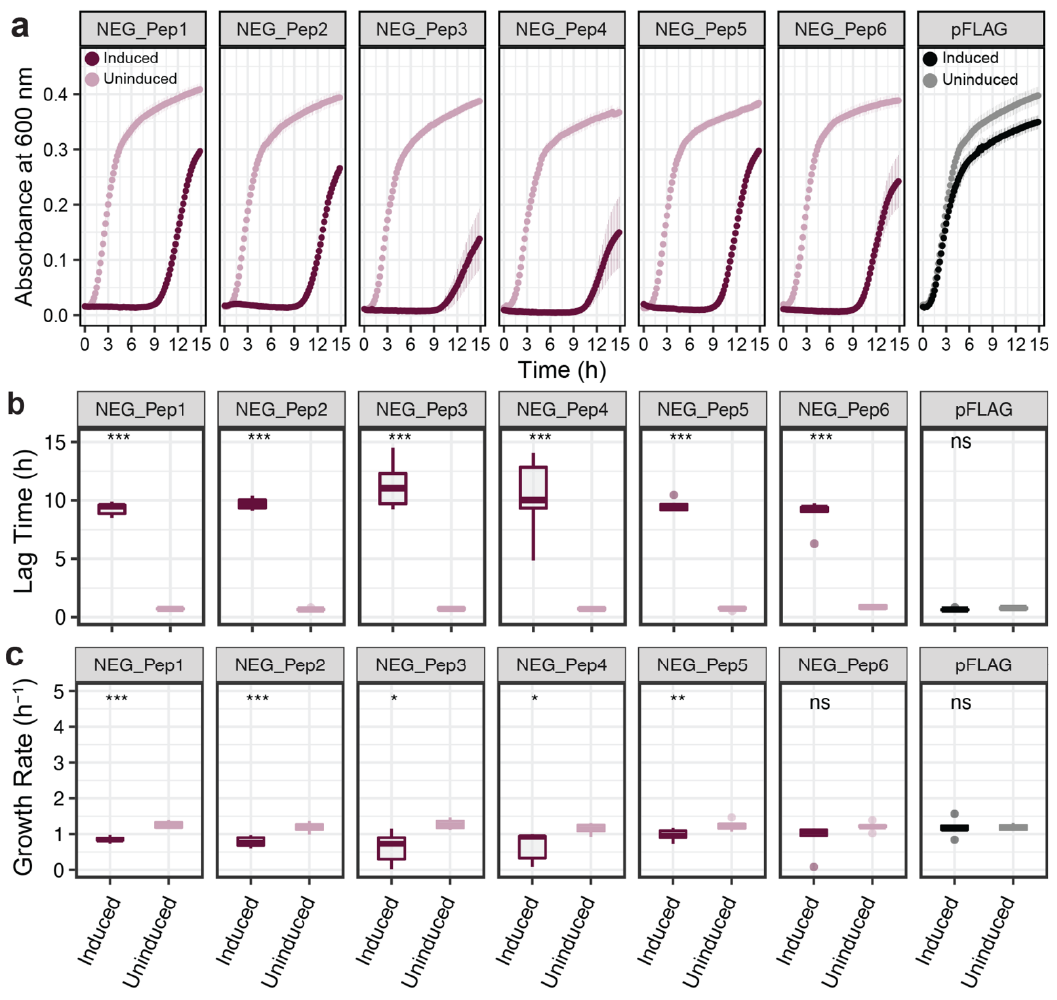
Figure 2. Growth rate comparisons for NEG_Pep clones compared to empty vector. ( a ) Growth curves without IPTG induction are depicted as light colors and with IPTG induction are in dark colors. OD 600 was recorded every 10 min with at least five replicates for each clone and condition. Dots represent means and whiskers, showing the standard error of the mean (SEM) across replicates. ( b ) Lag time comparisons between the six clones, measured as the time from the start of the experiment until the start of the exponential growth. ( c ) Growth rate comparisons between the six clones after the end of the lag phase. Boxplots show medians with lower and upper hinges corresponding to the 1st and 3rd quartiles. Student’s t -test was performed with p -values as follows: *** = p < 0.001, ** = p < 0.01, * = p < 0.05, ns = p >